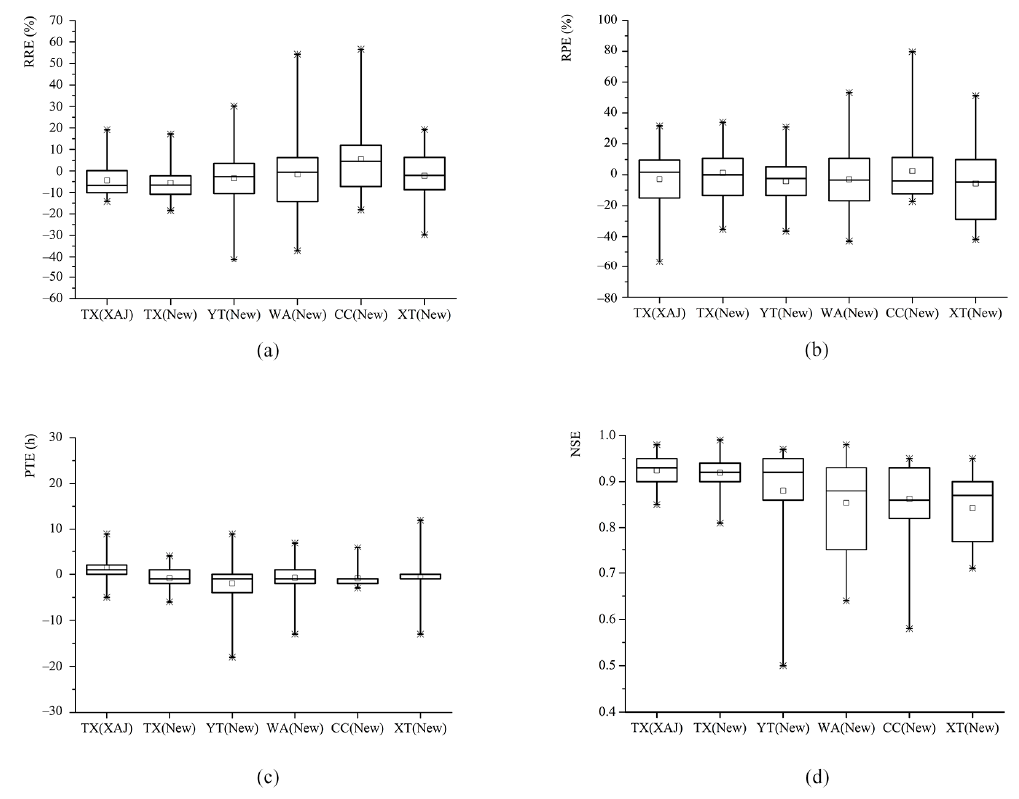
Figure 6. Box plots of the relative runo ff volume error (RRE), relative peak discharge error (RPE), peak time error (PTE) and Nash–Sutcli ff e e ffi ciency (NSE) statistics of all events by the original Xin’anjiang model (XAJ) and the new routing scheme at the catchment outlet TX and interior locations Yuetan (YT), Wanan (WA), Chengcun (CC) and Xinting